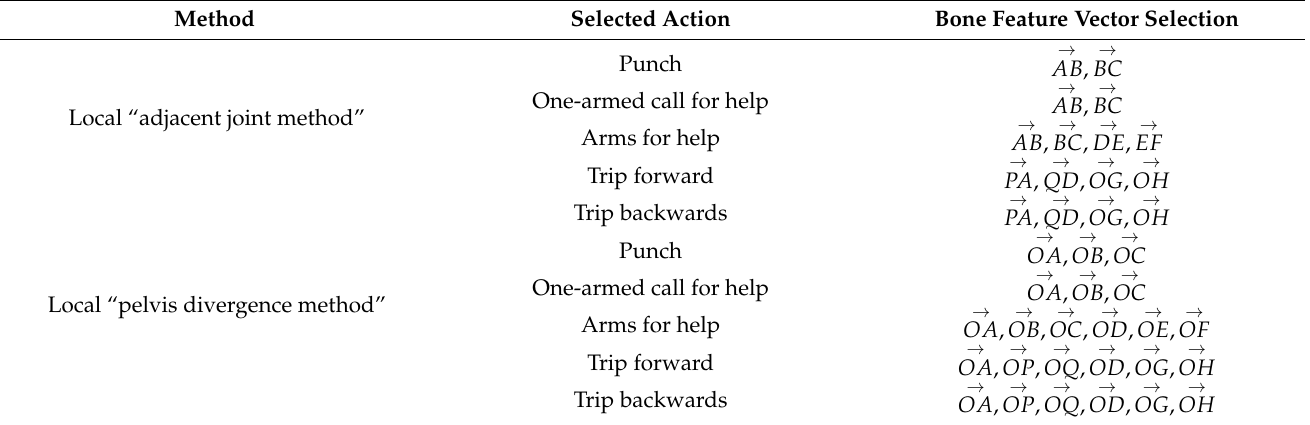
Table 5. Local action vector